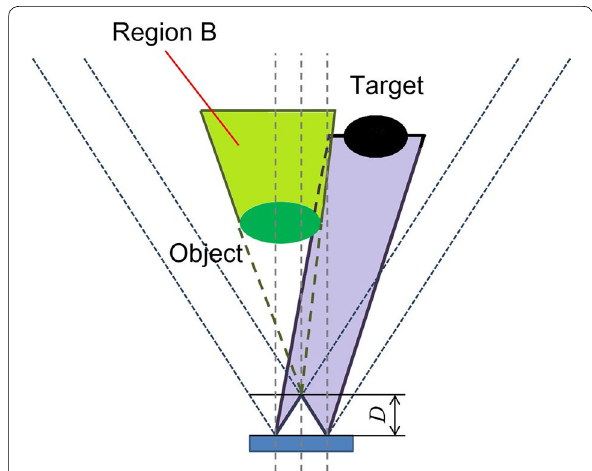
Fig. 9 The situation when the object does not violate Region A. This state is also determined to be STATE 2 because of the margins attached to the target’s